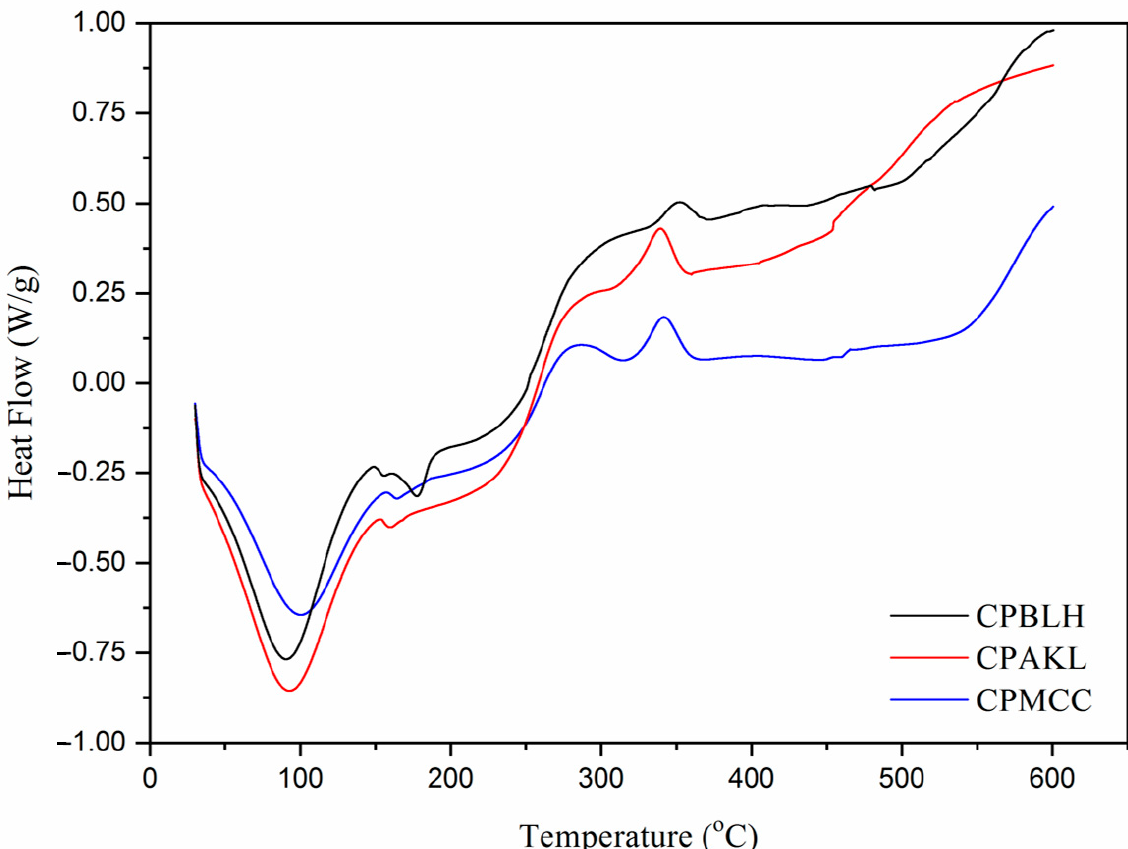
Figure 6. DSC curves of CPBLH, CPAKL, and CPMCC Figure 5. ( a ) TGA and ( b ) DTG curves of CPBLH, CPAKL, and CPMCC samples. Table 2. Thermal analysis data of CPBLH, CPAKL, and CPMCC.